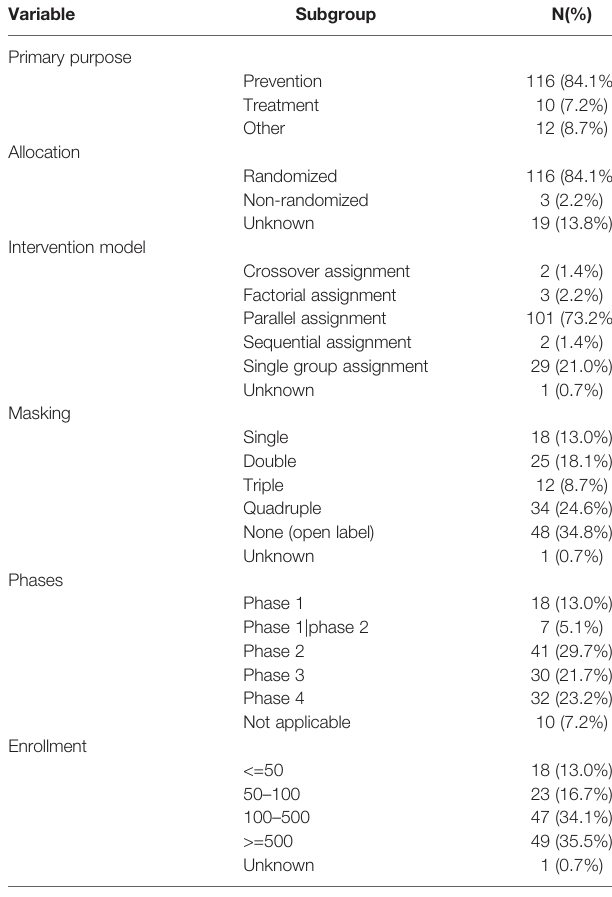
TABLE 1 | Characteristics of all included trials. TABLE 2 | Study design of all included